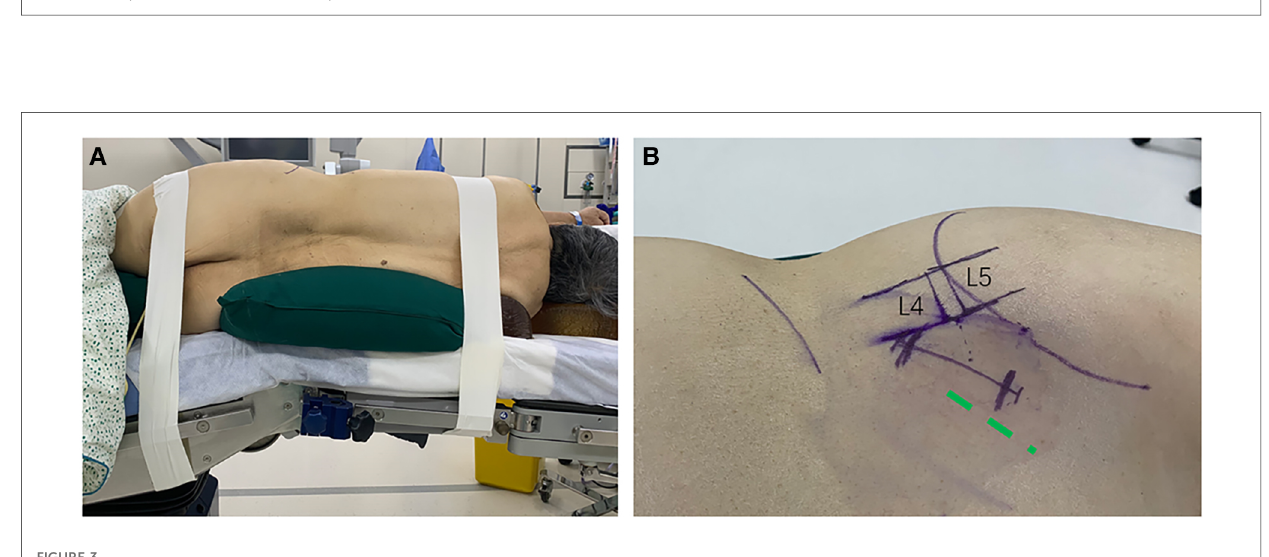
P indicates psoas, OC indicates oblique